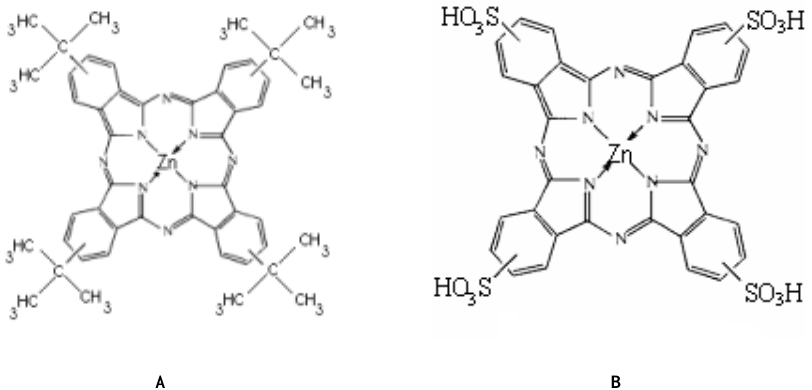
FIGURE 1 . Chemical structures of the photosensitizers: (A) tetra tertiary butyl zinc phthalocyanine (TBZnPc), (B) zinc phthalocyanine tetrasulfonic acid